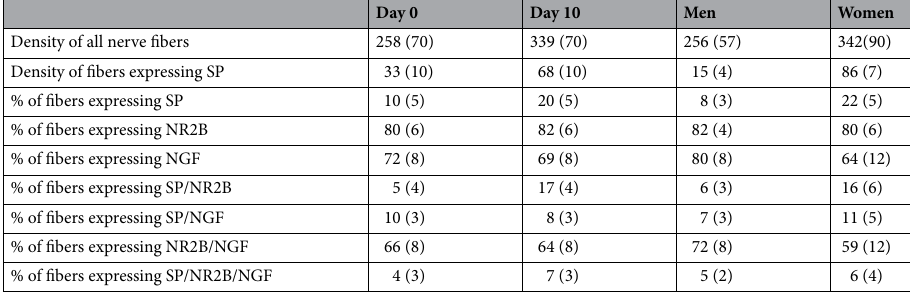
Table 2. The density and expression of nerve fibers associated with myocytes. The table presents the mean (SEM) of nerve fibers density (fibers/area on mm 2 ), the density of fibers expressing SP (putative afferent fibers) and the frequency of nerve fibers expressing markers alone and in combination on day 0 and 10 as well as from men and women.